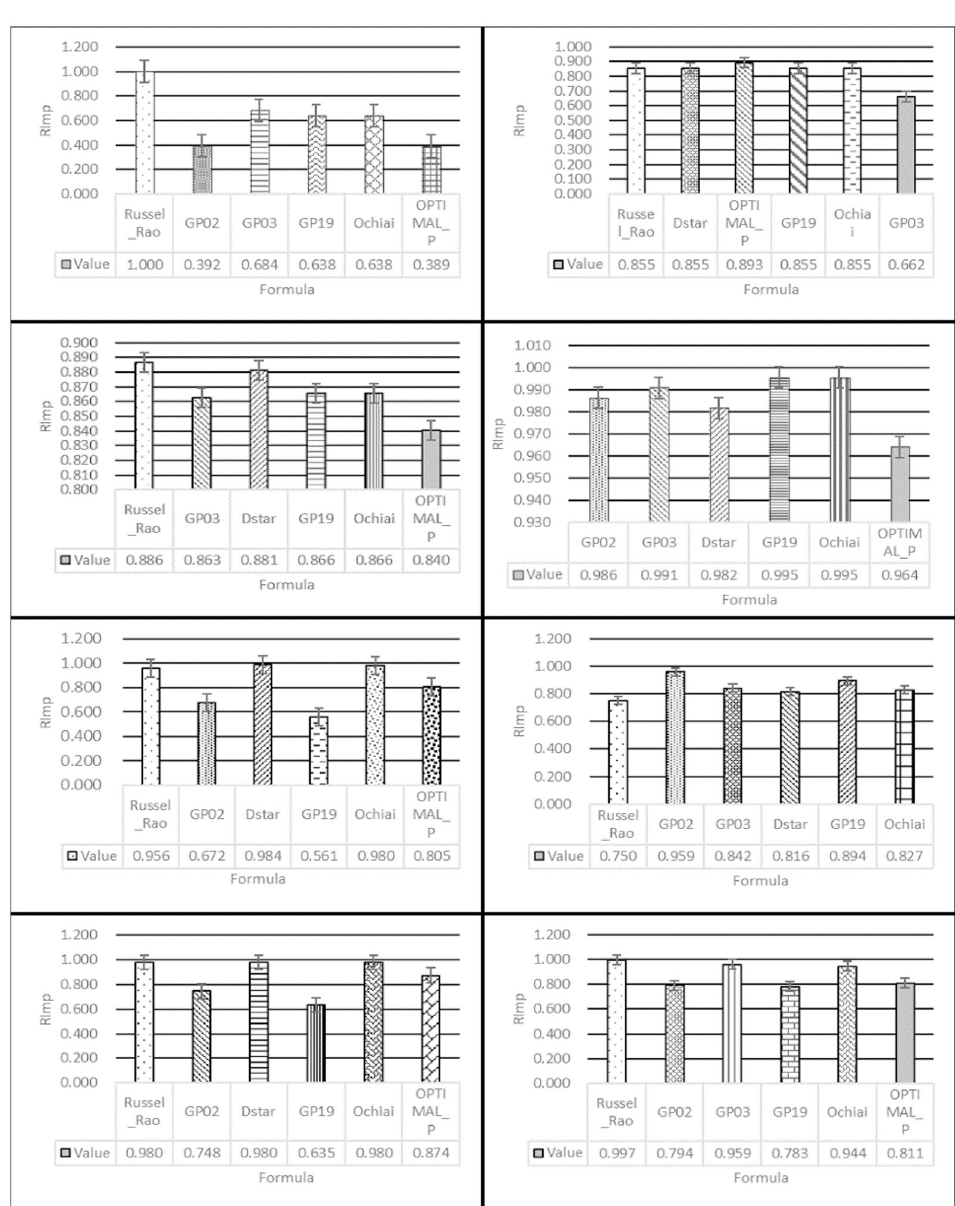
Fig 5. RImp comparison of remaining evaluation metrics. (a): The RImp of Dstar over others on AES. (b): The RImp of Dstar over others on Cordic. (c): The RImp of Dstar over others on FPU. (d): The RImp of Dstar over others on SHA256. (e): The RImp of Dstar over others on Pci. (f): The RImp of Dstar over others on Uart. (g): The RImp of Dstar over others on USB. (h): The RImp of Dstar over others on all faulty versions.